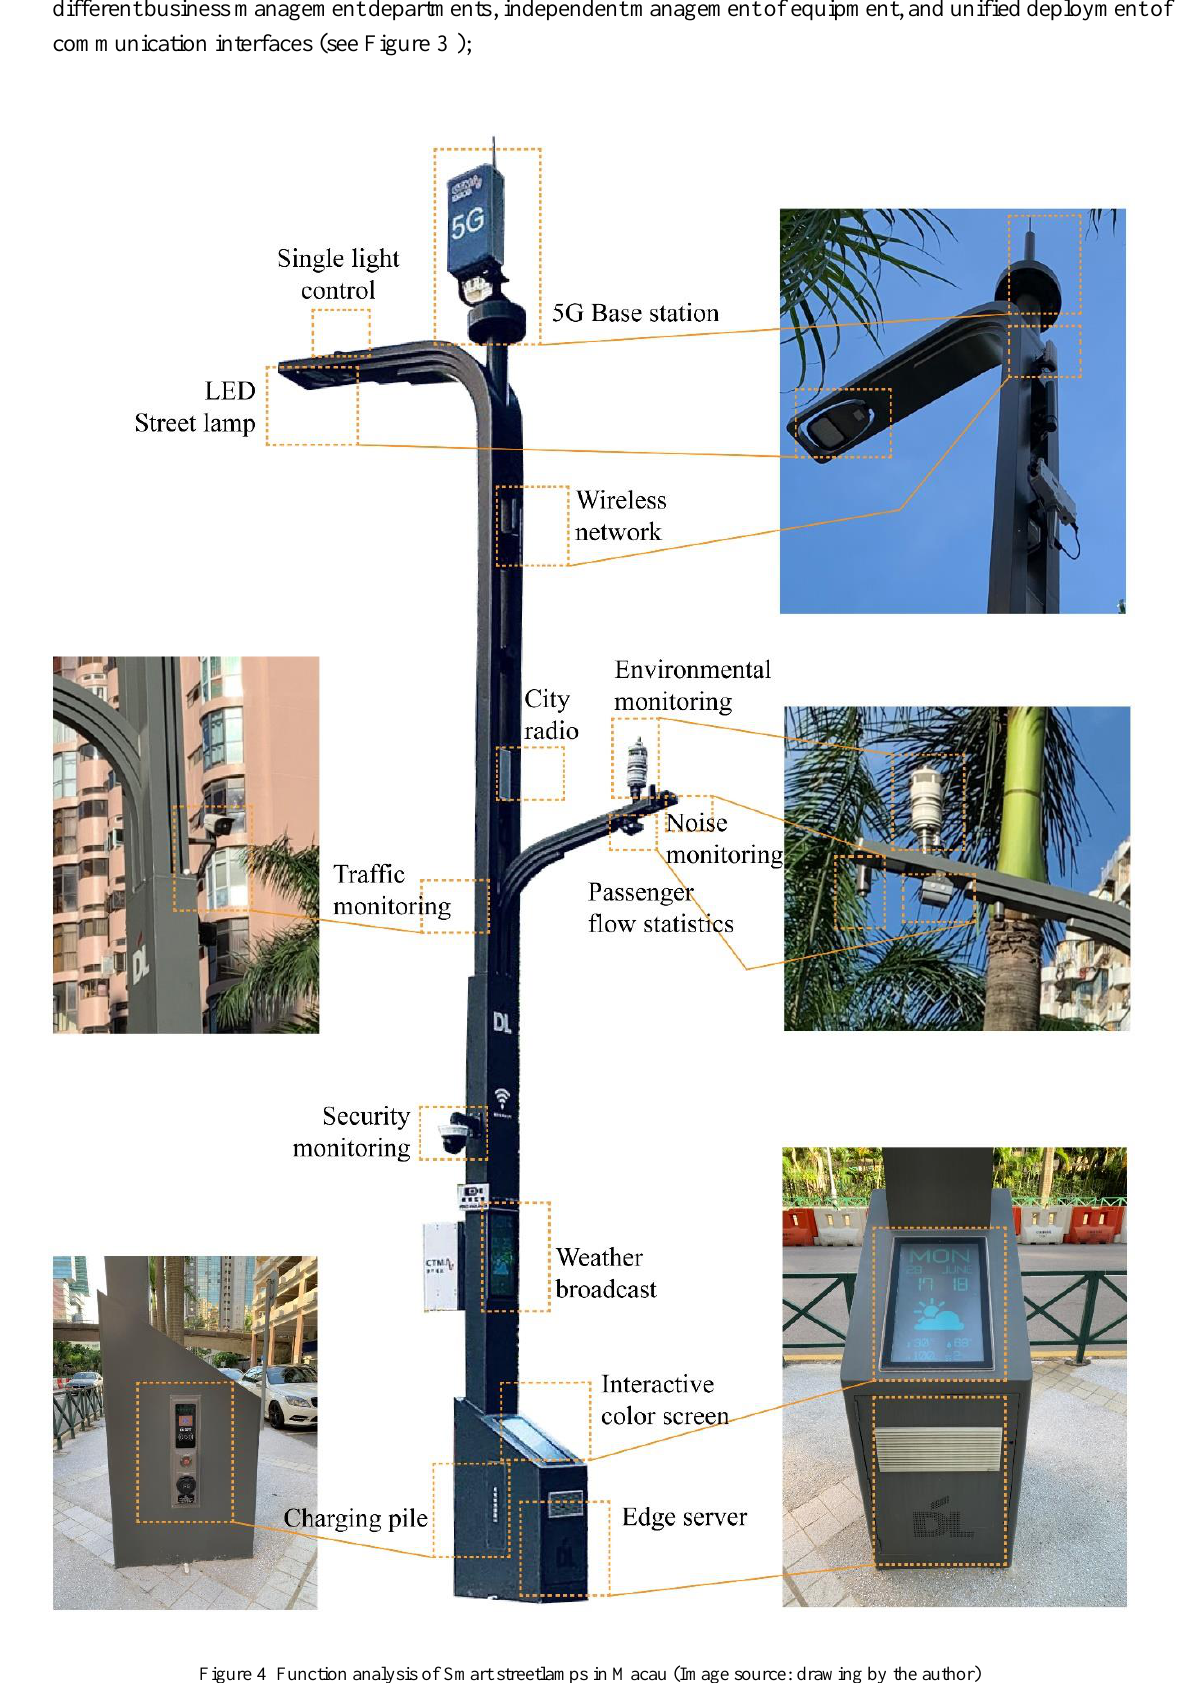
Figure 4 Function analysis of Smart streetlamps in Macau (Image source: drawing by the